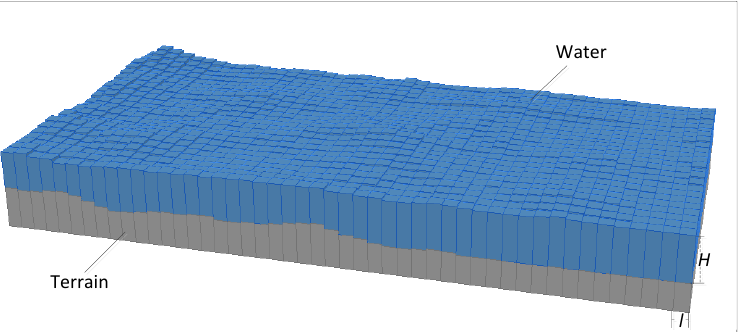
Figure 3. The concept map of water division of the short-lived water cuboid particle model.